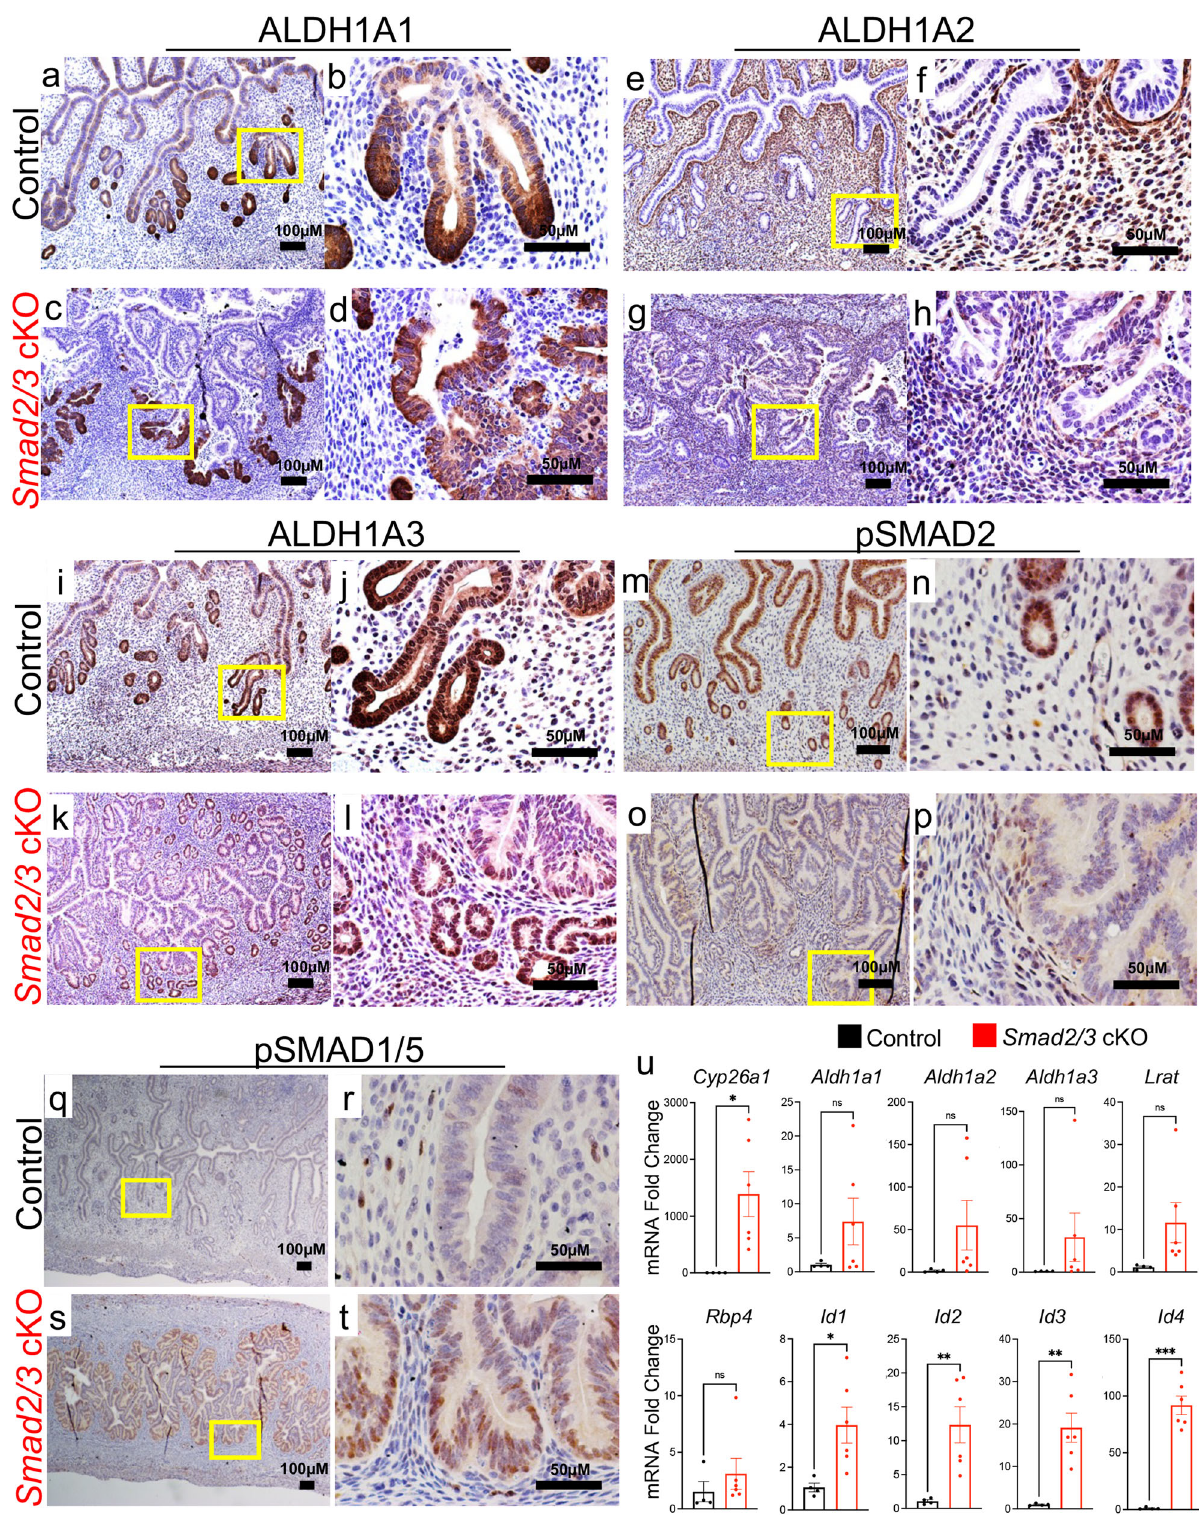
Generation of endometrial organoids . Endometrial organoids were established following the methods and culture conditions described by Boretto et al. 7 , with minor changes 72 . Speci fi cally, once the isolated epithelium in a single cell sus- pension were obtained as described above, the cell pellets were encapsulated in ice- cold Matrigel (Corning, 354230) at a 1:20 ratio of cell pellet volume:Matrigel (i.e., a 10µl cell pellet was resuspended in 200 µl Matrigel), and allowed to solidify at room temperature for 10 min in a 1.5ml Eppendorff tube. Once the Matrigel was solid, a wide-bore 200 µl pipette was used to dispense 3 – 25 µl domes into a 12-well